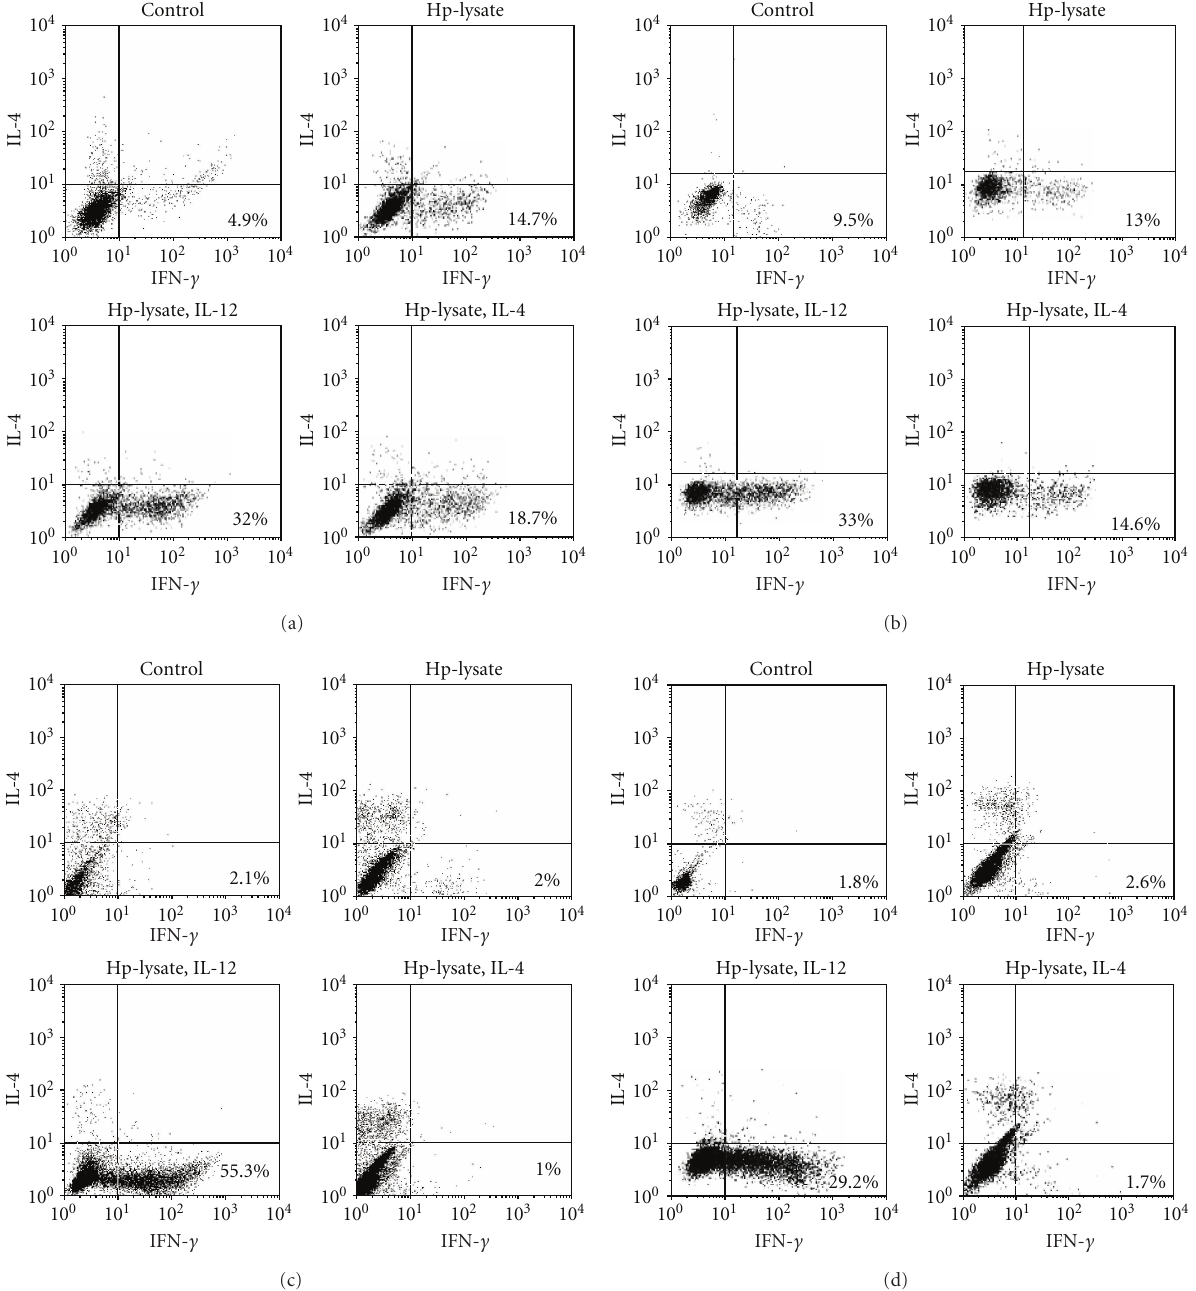
Figure 4: Flow cytometric analyses of e ff ector cells . Typical subsets analysis of CD4 + (a) and CD8 + (b) lymphocytes from GU patients, and CD4 + (c) and CD8 + (d) lymphocytes from CG patients are shown. H. pylori lysate induced the expression of IFN- γ in CD4 + cells regardless of additional cytokine stimulations, while CG indicated the expression of IFN- γ in CD4 + cells only by IL-12 stimulation. The same tendency was observed in CD8 +